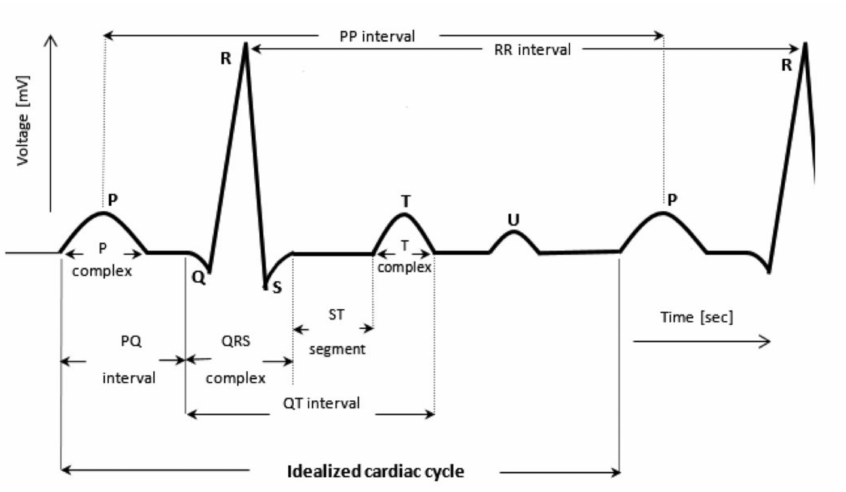
Figure 3. ECG cycle in a healthy and normal heart [28].